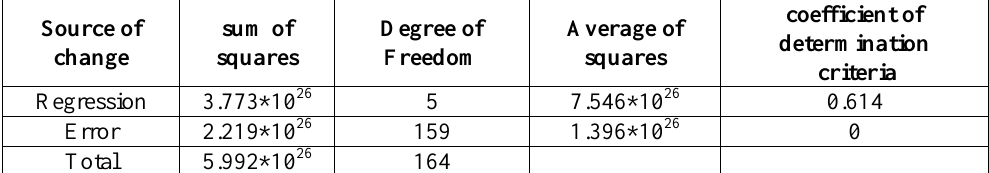
linear regression sum of Degree of Average of squares Freedom squares